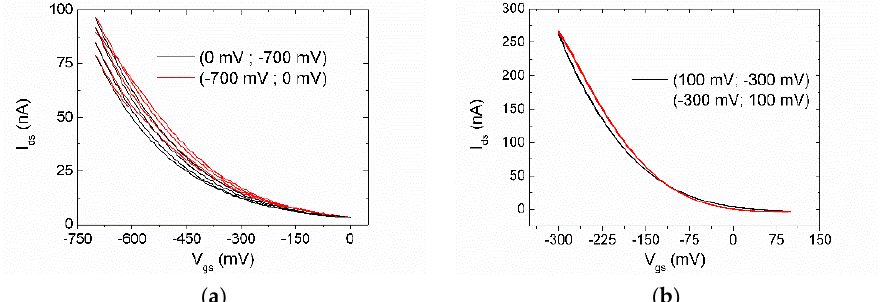
Figure 4. Transfer characteristics measured multiple times of EGOFET fabricated using P3HT dissolved in: ( a ) toluene without adhesion promoter; ( b ) oDCB with Ti prime adhesion